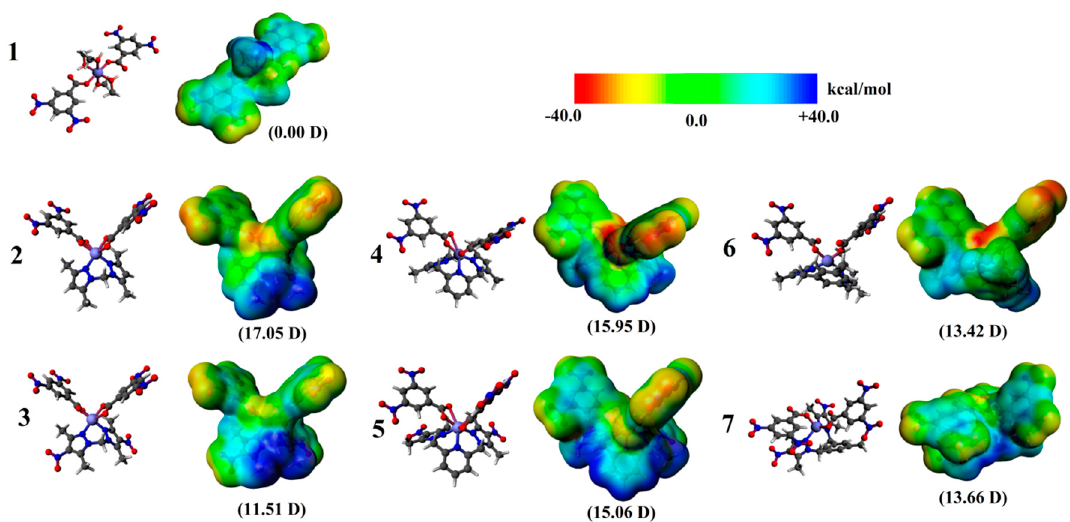
Figure 7. Relaxed structures, molecular electrostatic potential (MEP) energy surface and calculated dipole moment on a surface set at 0.001 a.u.